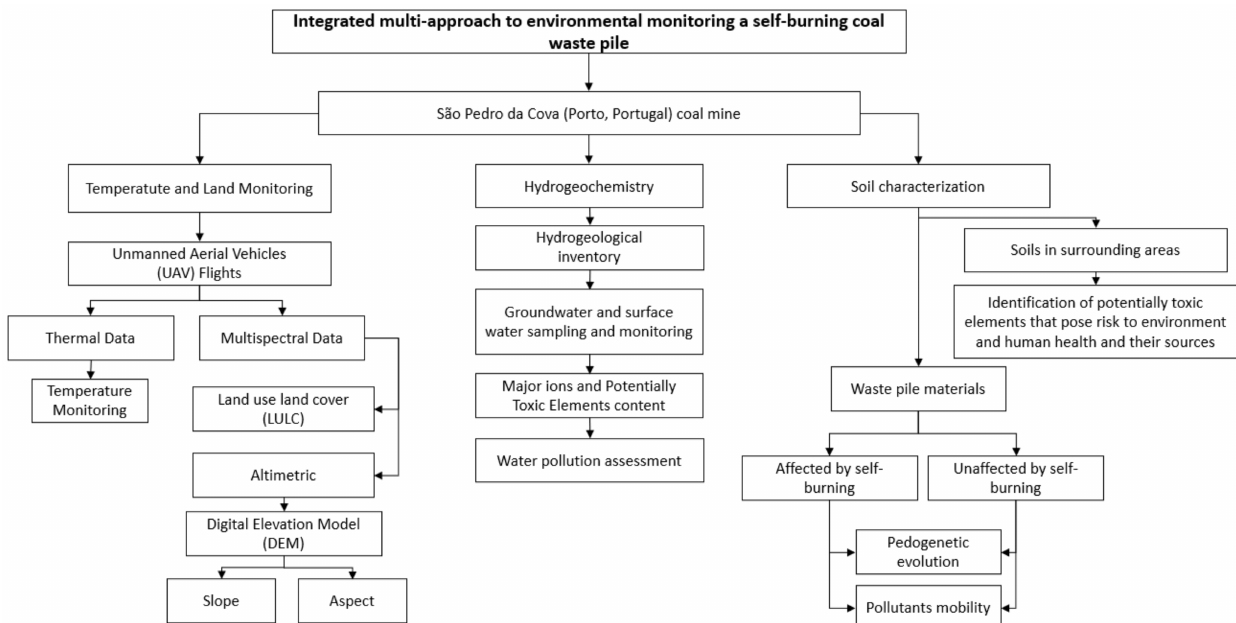
Figure 1. Workflow of the multi-approach followed in this work.